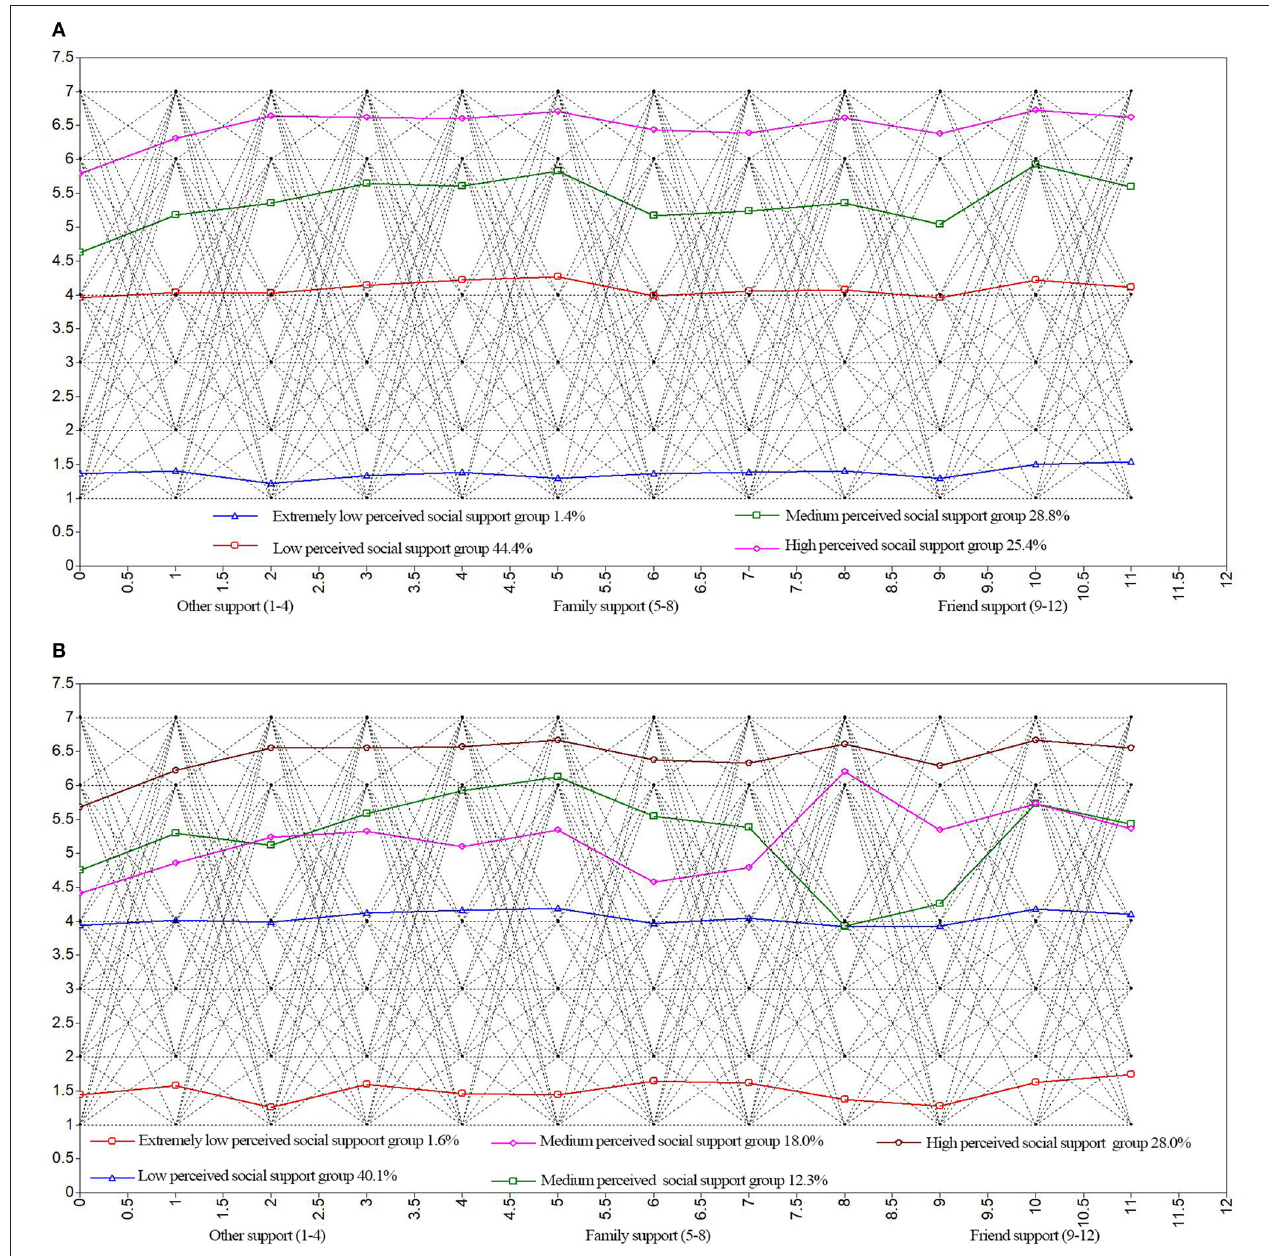
FIGURE 1 | (A) Four and (B) Five classes of perceived social support of the overall population. ELSSPG, Extremely low perceived social support group; LPSSG, Low perceived social support group; MPSSG, Medium perceived social support group; HPSSG, High perceived social support